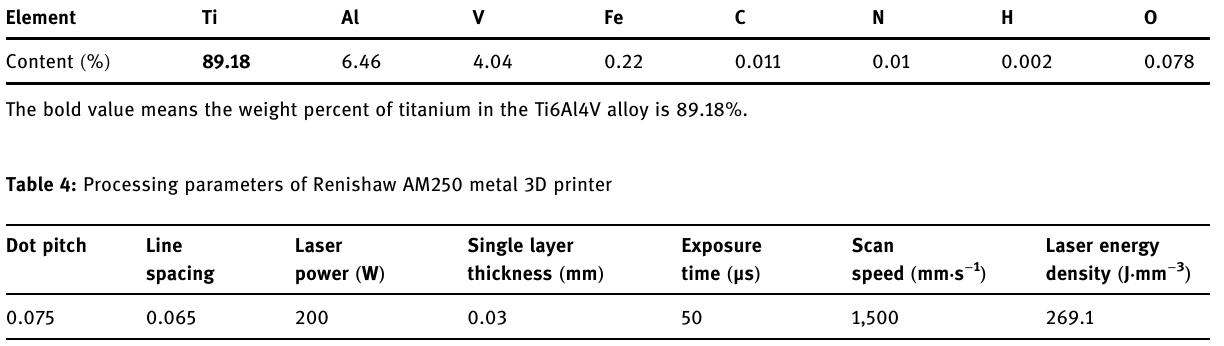
Table 3: Chemical composition of Ti6Al4V titanium alloy powder Element Ti